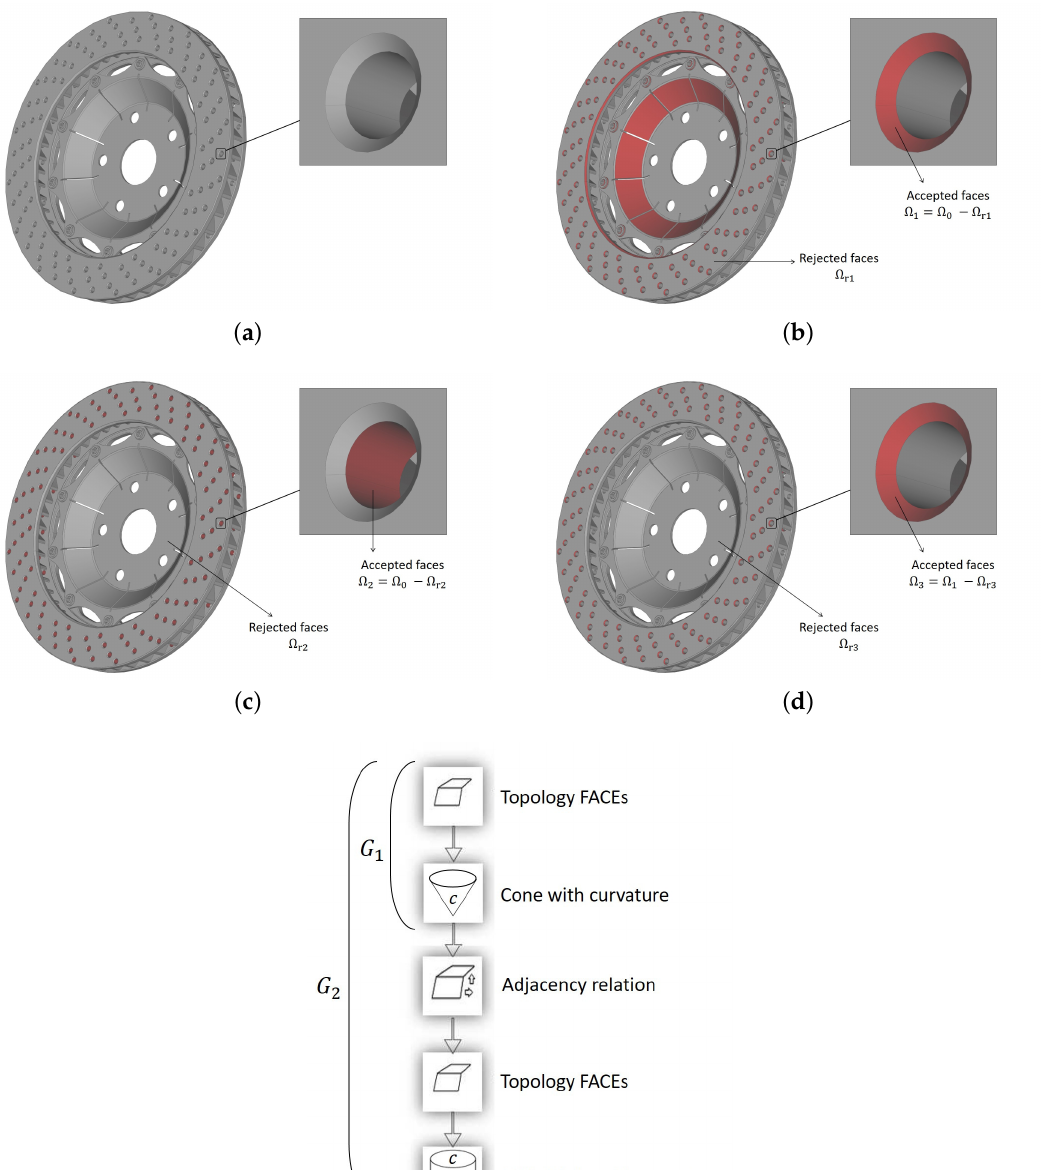
Figure 17. Results-Example 4: Recognition of holes chamfer surface in data set 4. ( a ) Initial data set Ω 0 , ( b ) Reduced domain and ( e ) Search graphs G 1 and G 2